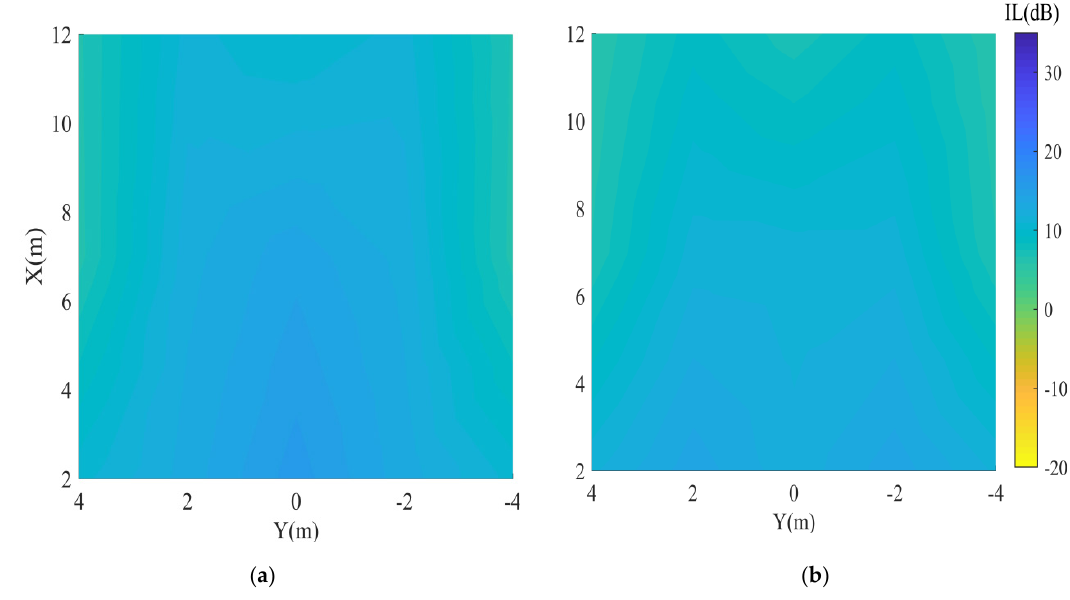
Figure 6. Insertion loss (dB) in the street area when the noise source is at d pr = 7 m and the control zone is ( a ) the street area (( X s , Z s ) = ( − 0.5, 1.8), ( X e , Z e ) = (0.4,0.2)) and ( b ) the shadow zone on the façade (( X s , Z s ) = ( − 0.5, 2.3), ( X e , Z e ) = (0.3,0.4)).